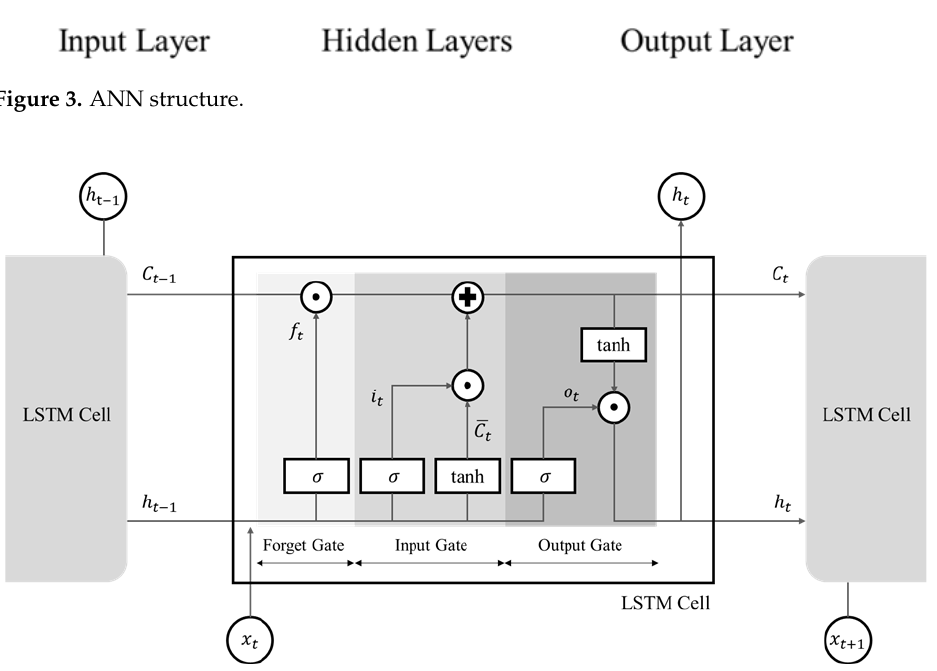
Appl. Sci. 2022 , 12 , x FOR PEER REVIEW